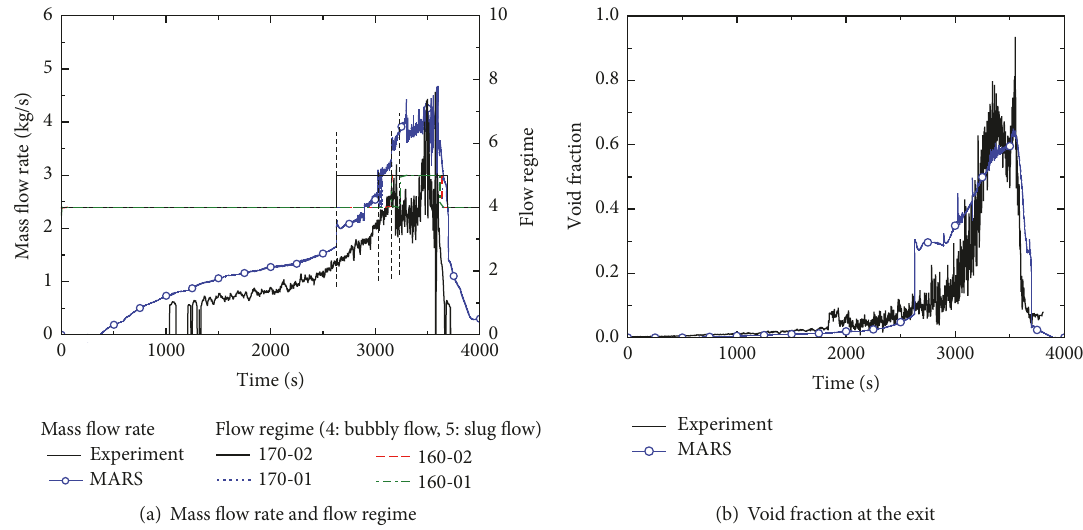
Figure 15: The effects of flow regime changes for Case